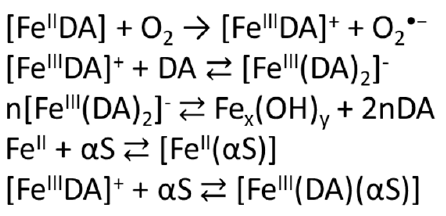
Figure 2. Kinetic traces of DA-Fe II (2:1) interaction as a function of Ac- α S 119–132 concentration ( λ max = 580 nm) in 10 mM Mops bu ff er pH 7.0, 37 °C, Fe II 0.1 mM, DA 0.2 mM (blue), and increasing amounts of Ac- α S 119–132 (0.5 equiv.: red, 1 equiv.: green, 1.5 equiv.: purple, 2 equiv.: black).